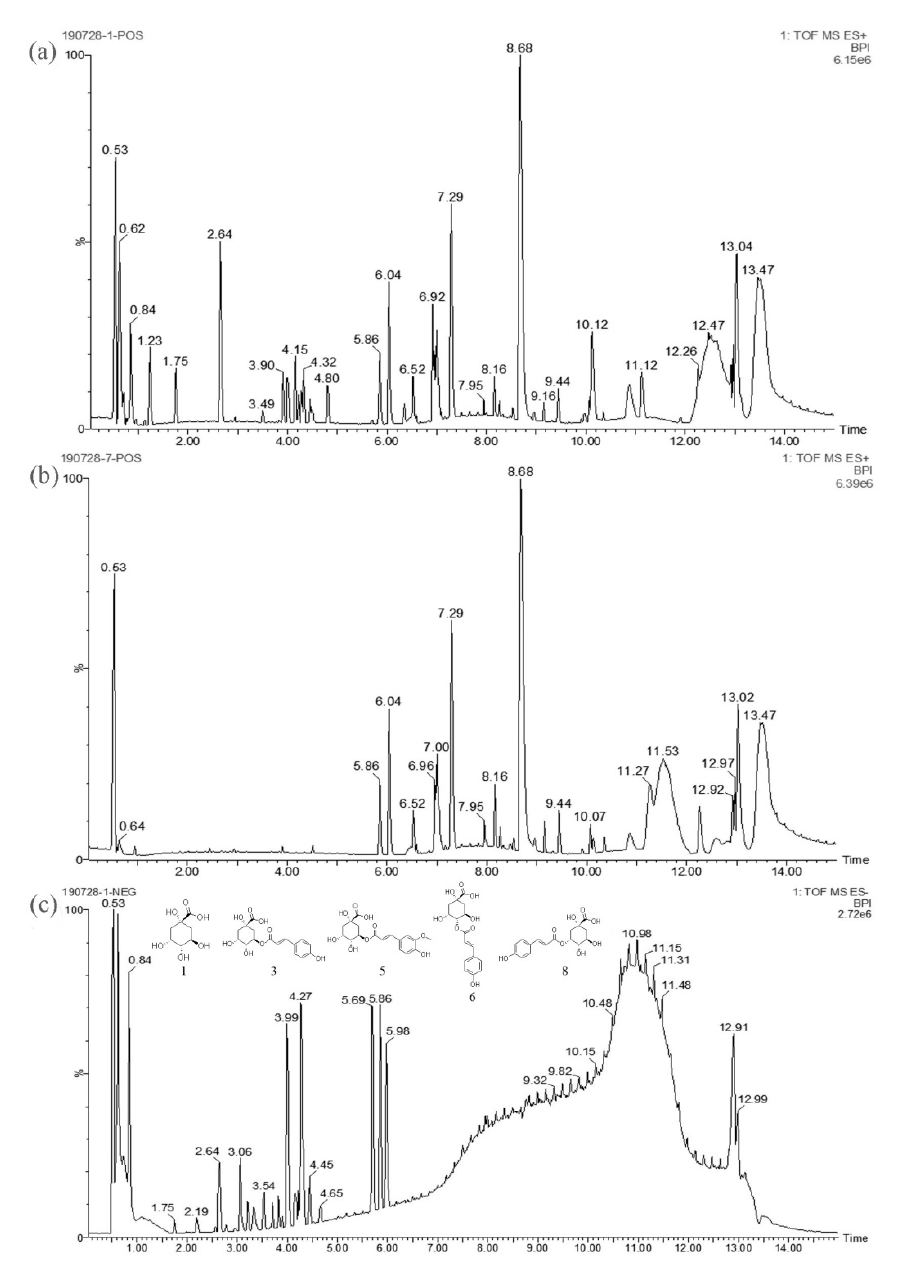
Figure 5. Ultra-high-performance liquid chromatography-tandem time-of-flight mass spectrometer (UPLC-HRMS) profile of C. rotundus aqueous extracts. ( a , c ) represent the aqueous extracts in positive and negative ionization mode, respectively. ( b , d ) represent the modified seawater in positive and negative ionization mode, respectively.